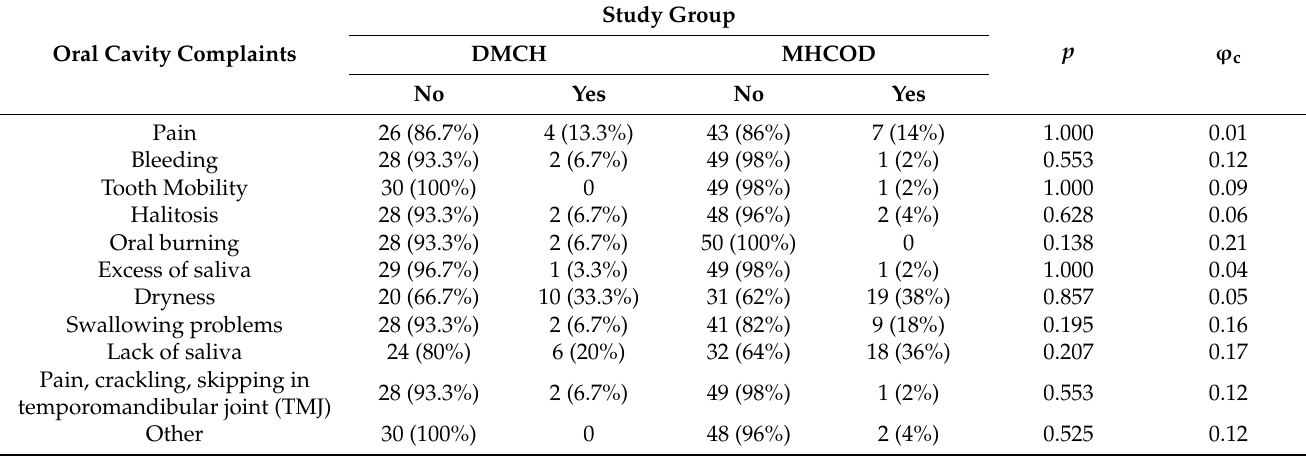
Table 1. The frequency of oral cavity complaints in both groups.